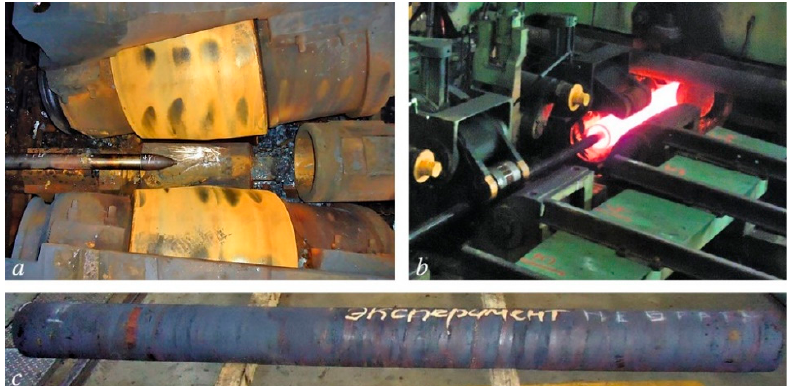
Figure 22. Forming inner hole of hollow axle by rotary piercing: ( a ) rolling mill; ( b ) billet piercing process; ( c ) steel pipe [26] (Reprinted with permission from Ref. [26]. 2023, Springer Nature).